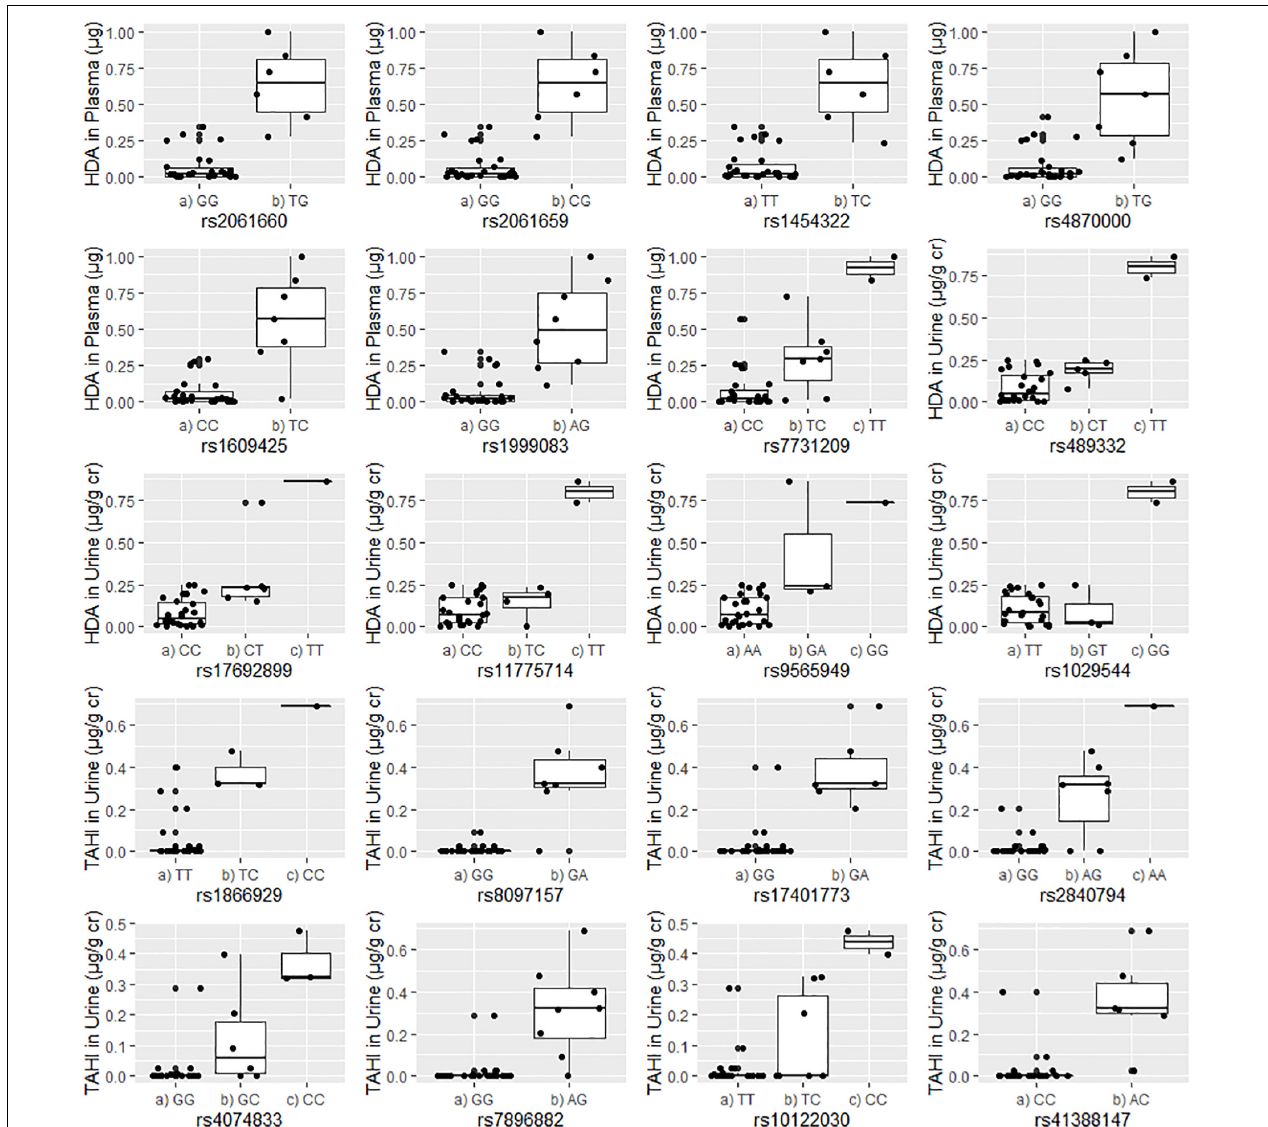
FIGURE 2 | Correlations between the unadjusted biomarker levels in urine or plasma and the genotypes for each of the 20 significant single-nucleotide polymorphisms (SNPs). Urine biomarker levels were adjusted with creatinine level ( µ g biomarker/g creatinine; µ g/g Cr). The homozygous major allele is preceded by “(a),” the heterozygous genotype is preceded by “(b),” and the homozygous minor allele is preceded by